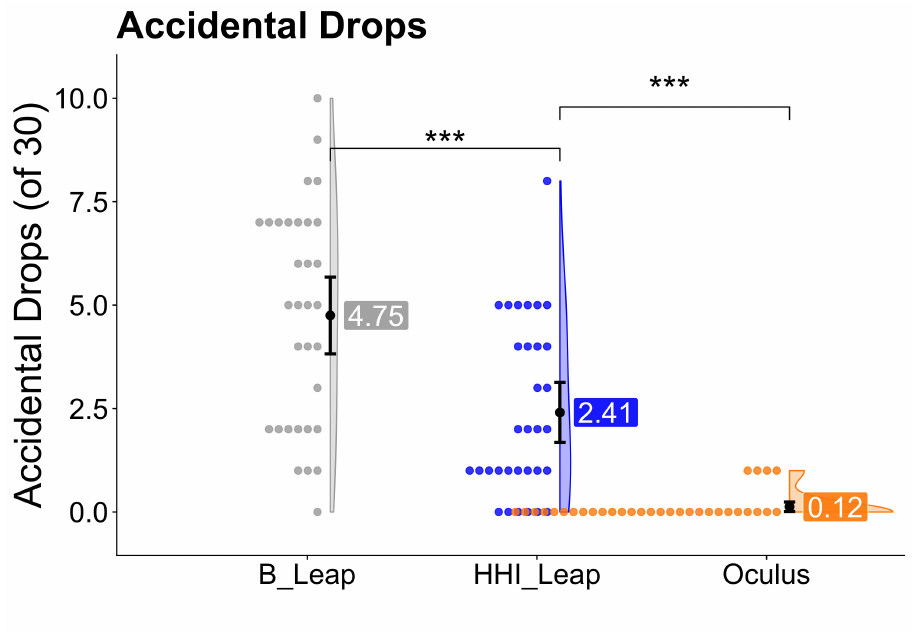
Figure 8. Accidental drops by interface, with means and 95% confidence intervals, individual participant counts (colored dots), smoothed density distributions and the results of paired-samples t -tests. *** = p < 0.001.